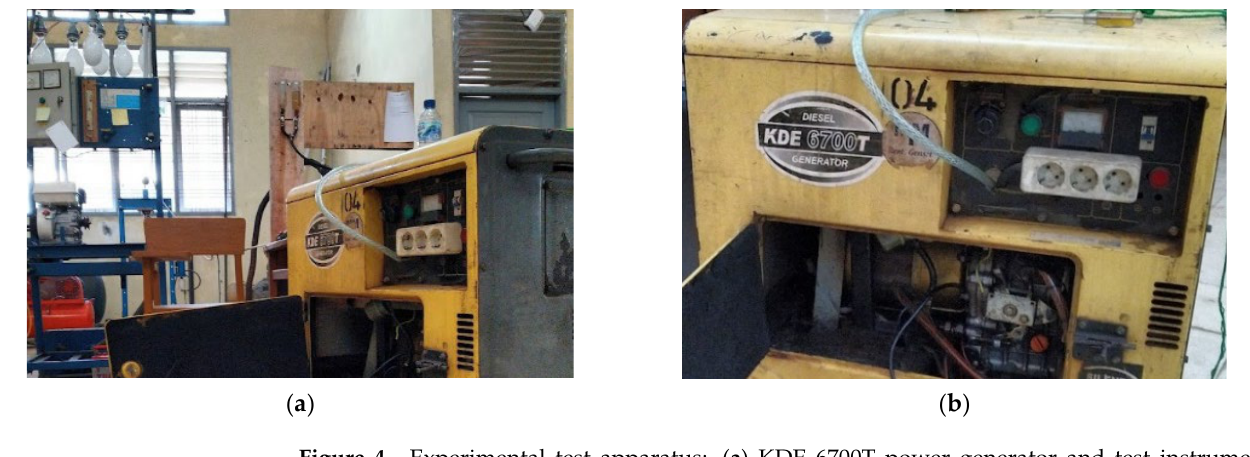
Figure 4. Experimental test apparatus: ( a ) KDE 6700T power generator and test instruments ( b ) modified external fuel line system bypassing default fuel tank.